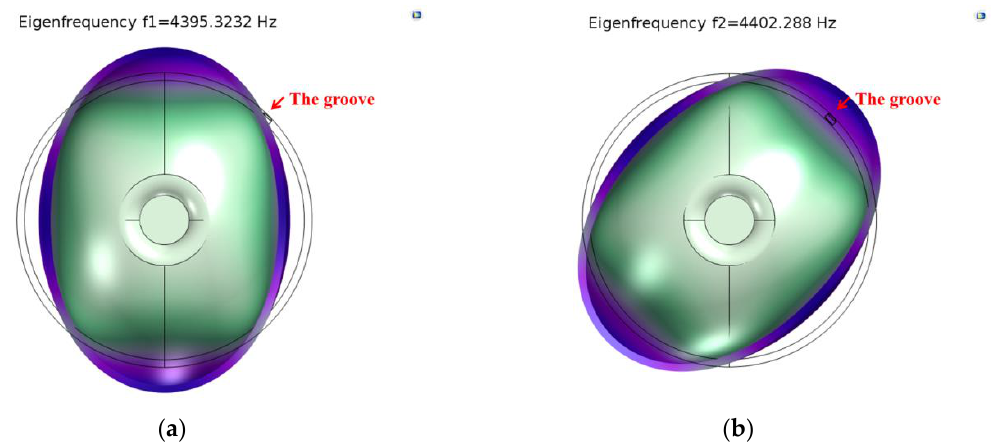
Figure 3. Eigen frequencies of the n = 2 mode before etching. ( a ) f 1 = 4395.3232 Hz; ( b ) f 2 = 4402.288 Hz .